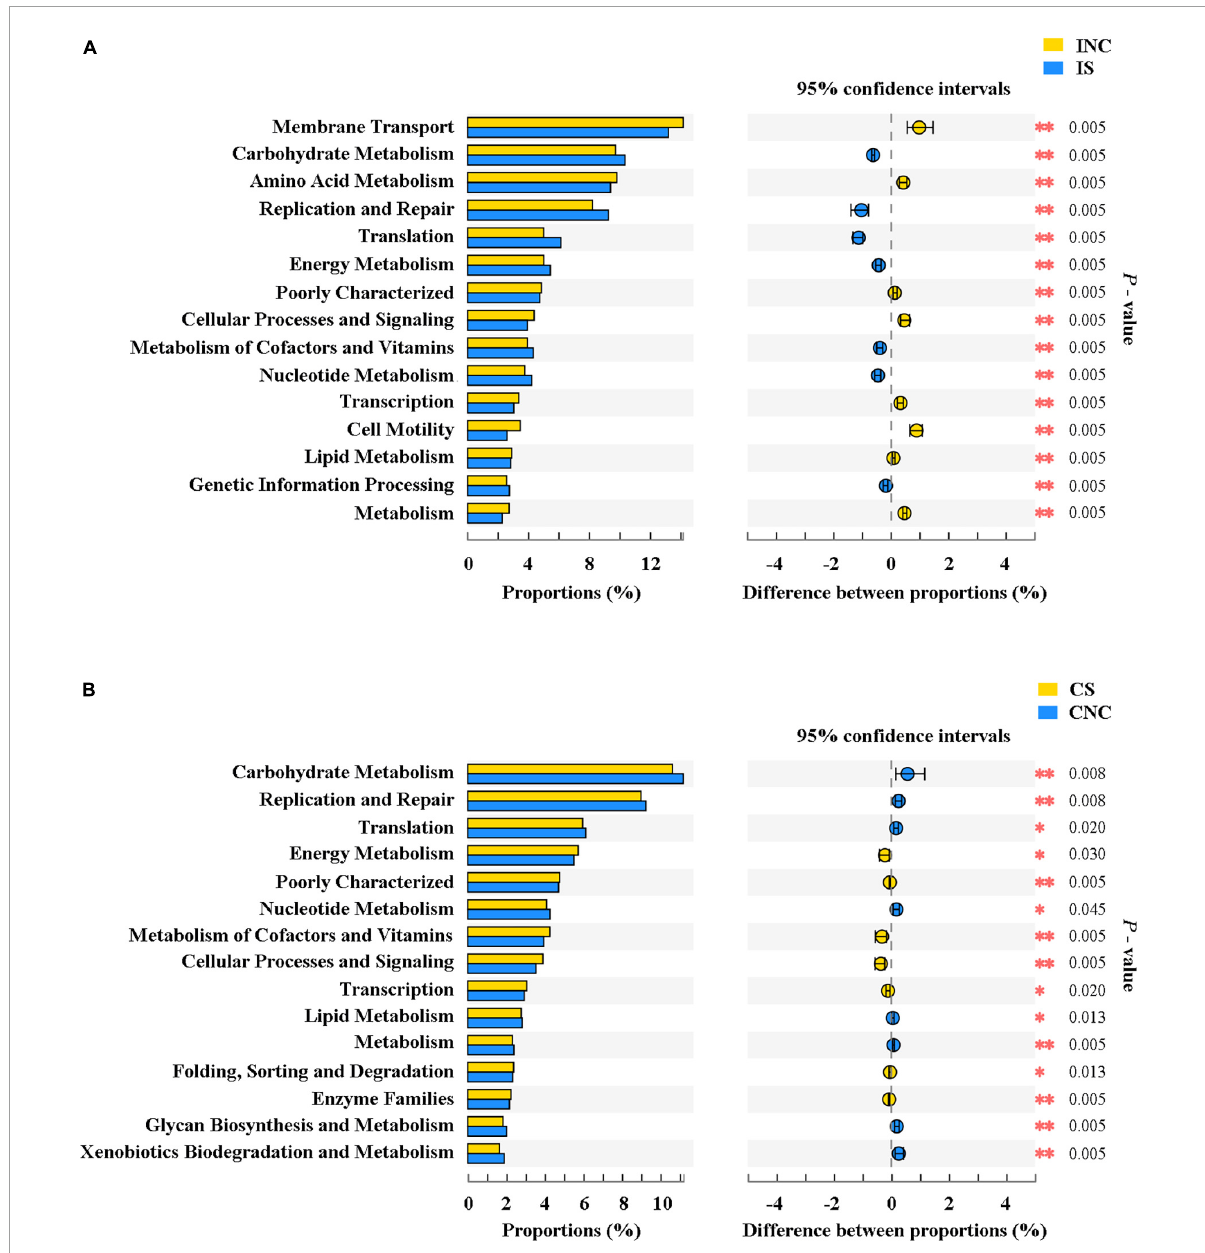
FIGURE7 The mean proportion and significant difference in predicted metabolism pathways (KEGG) between the control and treatment group from the ileum and the colon using PICRUSt. (A) KEGG pathways analysis of ileal bacteria between INC and IS. (B) KEGG pathways analysis of colonic bacteria between CNC and CS. INC, ileum negative control; CNC, colon negative control; IS, ileum with 0.2% sodium butyrate; CS, colon with 0.2% sodium butyrate. ∗ P < 0.05 and ∗∗ P <